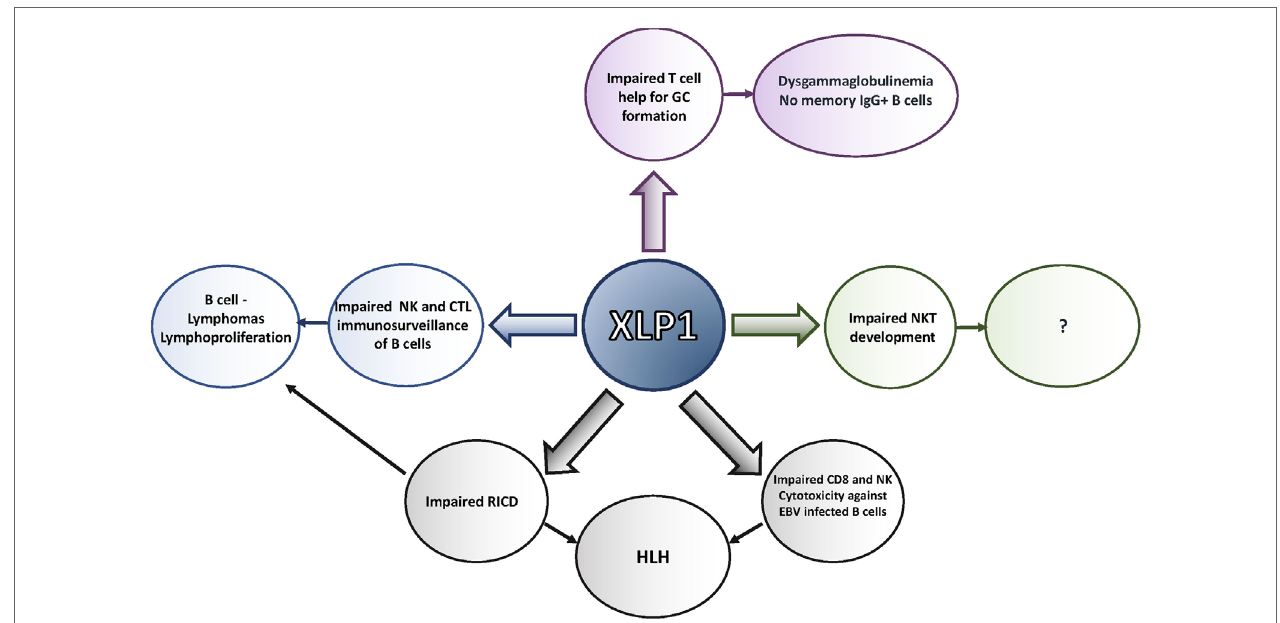
FiGURe 2 | Defects seen in X-linked lymphoproliferative disease (XLP)1. XLP1 is associated with multiple T and NK cellular defects, many of which may result from impaired interactions with B cells and other cells that express high levels of signaling lymphocyte activation molecule (SLAM) family members. These defects contribute to the phenotypes observed in the disease, including the inability to clear Epstein–Barr virus (EBV), lymphoproliferation and lymphoma, hemophagocytic lymphohistiocytosis (HLH), and antibody